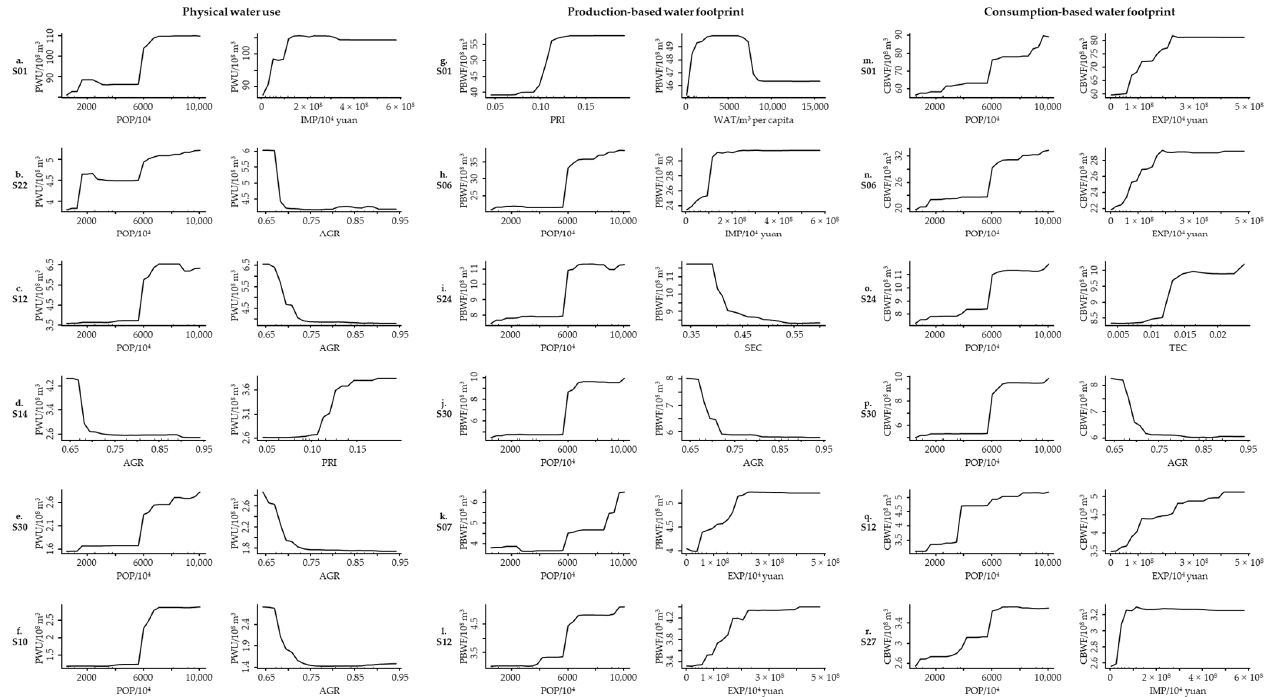
Figure 6. The influence intensity of the top two influencing factors in the top six sectors of physical water use, the production-based water footprint, and the consumption-based water footprint, 2007–2017: ( a )-S01 in PWU; ( b )-S22 in PWU; ( c )-S12 in PWU; ( d )-S14 in PWU; ( e )-S30 in PWU; ( f )-S10 in PWU; ( g )-S01 in PBWF; ( h )-S06 in PBWF; ( i )-S24 in PBWF; ( j )-S30 in PBWF; ( k )-S07 in PBWF; ( l )-S12 in PBWF; ( m )-S01 in CBWF; ( n )-S06 in CBWF; ( o )-S24 in CBWF; ( p )-S30 in CBWF; ( q )-S12 in CBWF; ( r )-S27 in CBWF. (PWU refers to physical water use, PBWF refers to the production-based water footprint, and CBWF refers to the consumption-based water footprint).